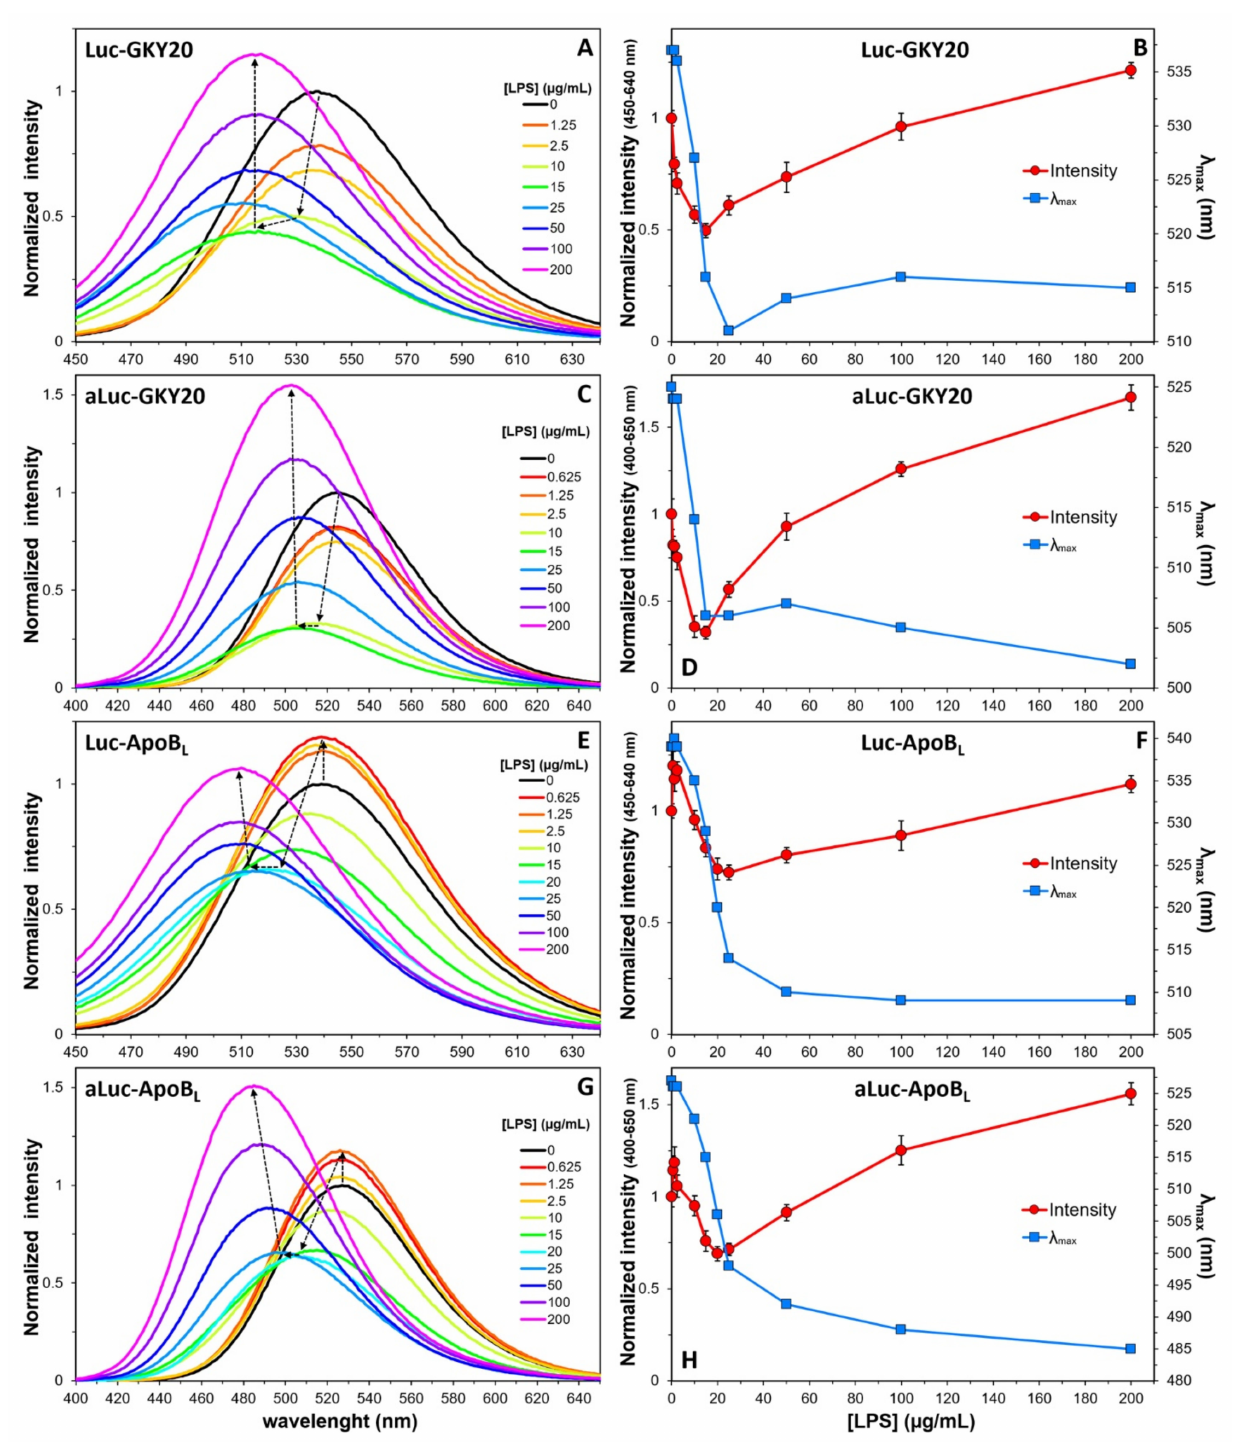
Figure 4. Fluorescence of the labeled peptides in the presence of increasing concentrations of LPS (0–200 µ g/mL). ( A , C , E , G ) Emission spectra of the peptides recorded after excitation at 330 nm (Luc-labelled peptides) and 363 nm (aLuc- labelled peptides). Spectra recorded in the presence of LPS were normalized to the corresponding spectra recorded in NaP (black lines). Arrows highlight the main changes with respect to NaP. ( B , D , F , H ) Variation of total fluorescence (in the indicated ranges) and of the λ max values as a function of LPS